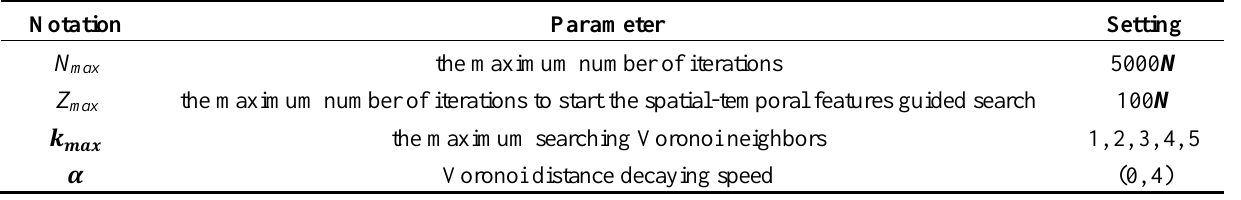
Table 1. Parameter settings of the STDVH